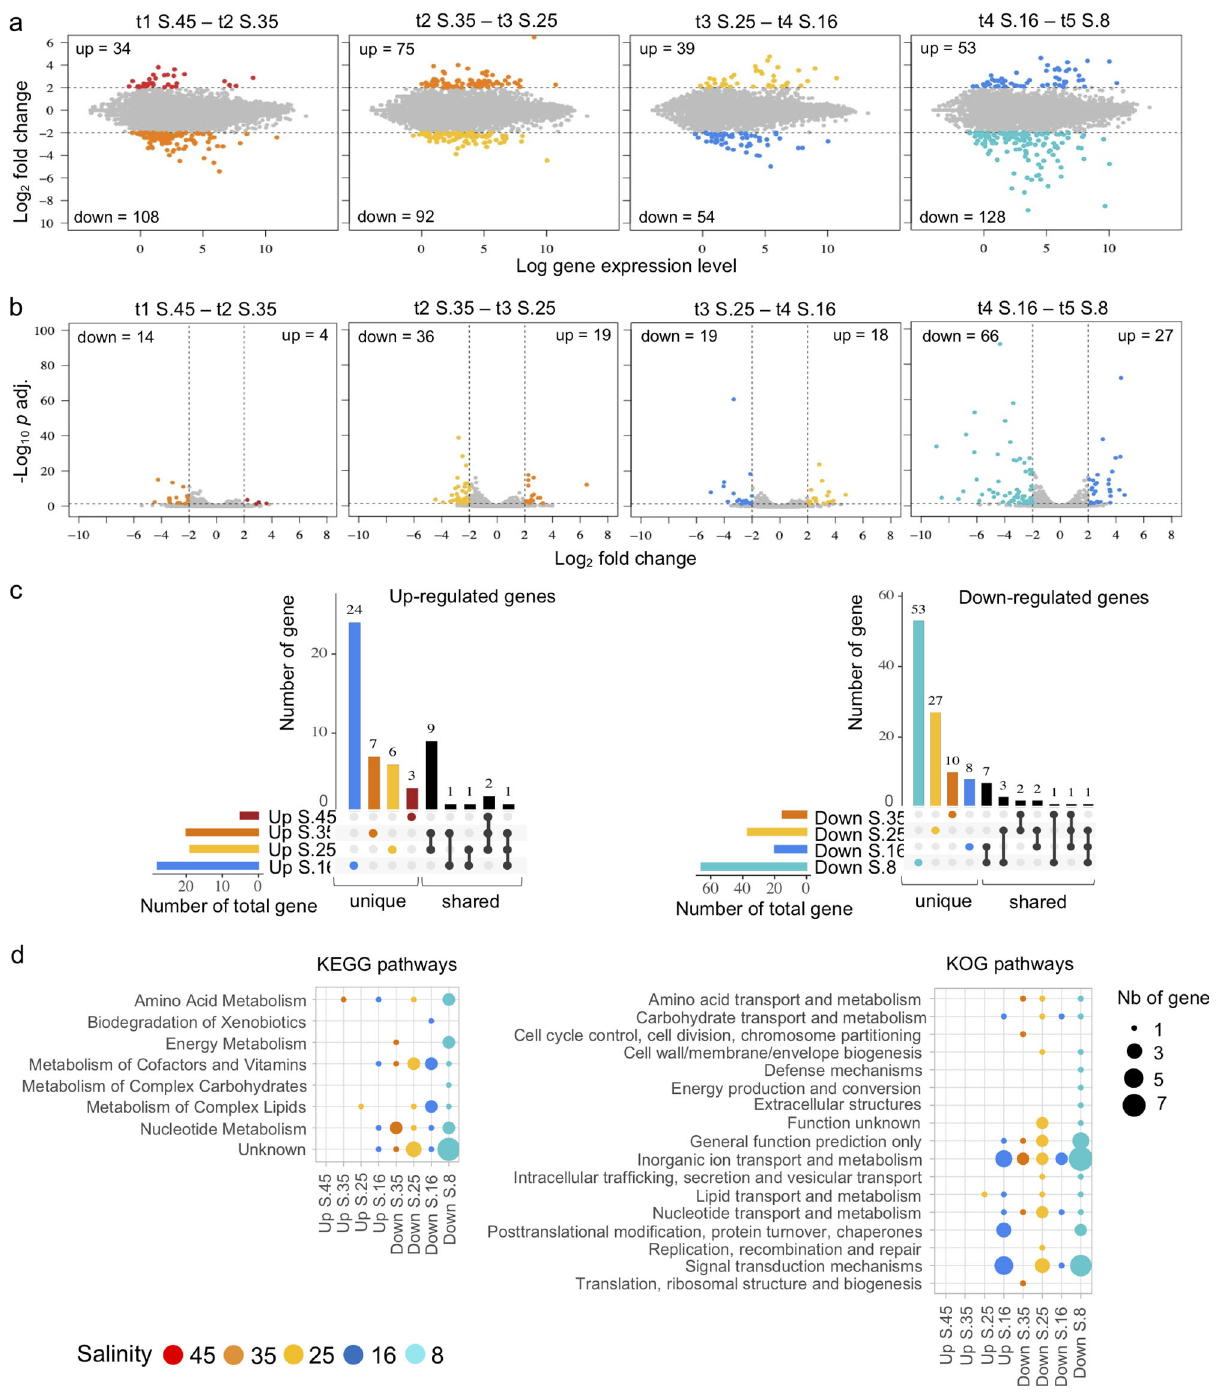
Fig. 3 Differential expression genes from a progressive change of salinity. a Comparison scatter plot of RNA-Seq analyses of the progressive salinity change. Each point represents a unigene. Points higher than 2 of log 2 fold change indicate genes upregulated and each point lower than − 2 of log 2 fold change indicate genes downregulated. Each number of up and downregulated genes are indicated. b Scatter plot of fi ltered up- and downregulated genes with an adjusted P value of <0.05. c UpsetR plot indicated shared and unique genes between the comparison of the condition of salinity. d KEGG and KOG pathways of up- and downregulated genes of each comparison between the change from a higher to lower salinity. Salinity treatments are indicated by colors from highest salinity (S.45) in red to lowest salinity (S.8) in “ Molecular Function ” categories, the greatest number of upregu- Process ” terms and hydrolases in the “ Molecular Function ” terms. lated genes were seen at S.16. For downregulated genes different Among others, signi fi cant DEGs at S.8 in ‘ Biological Process ’ were process were implicated at the different points, for example at involved with transport generally, and chloride, cation, electron, S.25 there were multiple DEGs associated with carbohydrate, and proton transports, whereas ion transport was upregulated at metabolic, and nucleotide catabolic processes in the “ Biological S.16 (Supplementary Fig. 7). In the “ Molecular Function ”